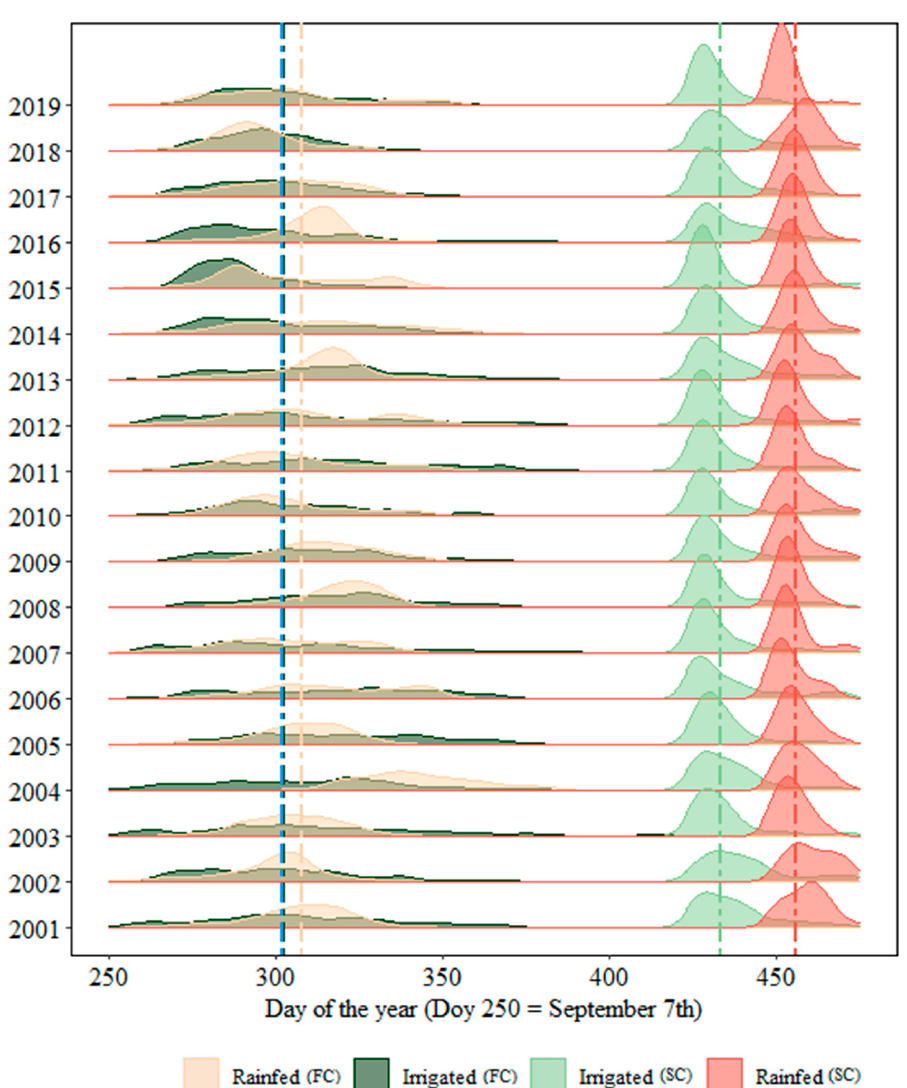
Figure 5. Distribution of rainy season onset, rainfed and irrigated sowing (first and second crop) dates from 2001 to 2019. Lines indicate the median of rainy season onset (blue) and sowing dates for each crop and management practice.